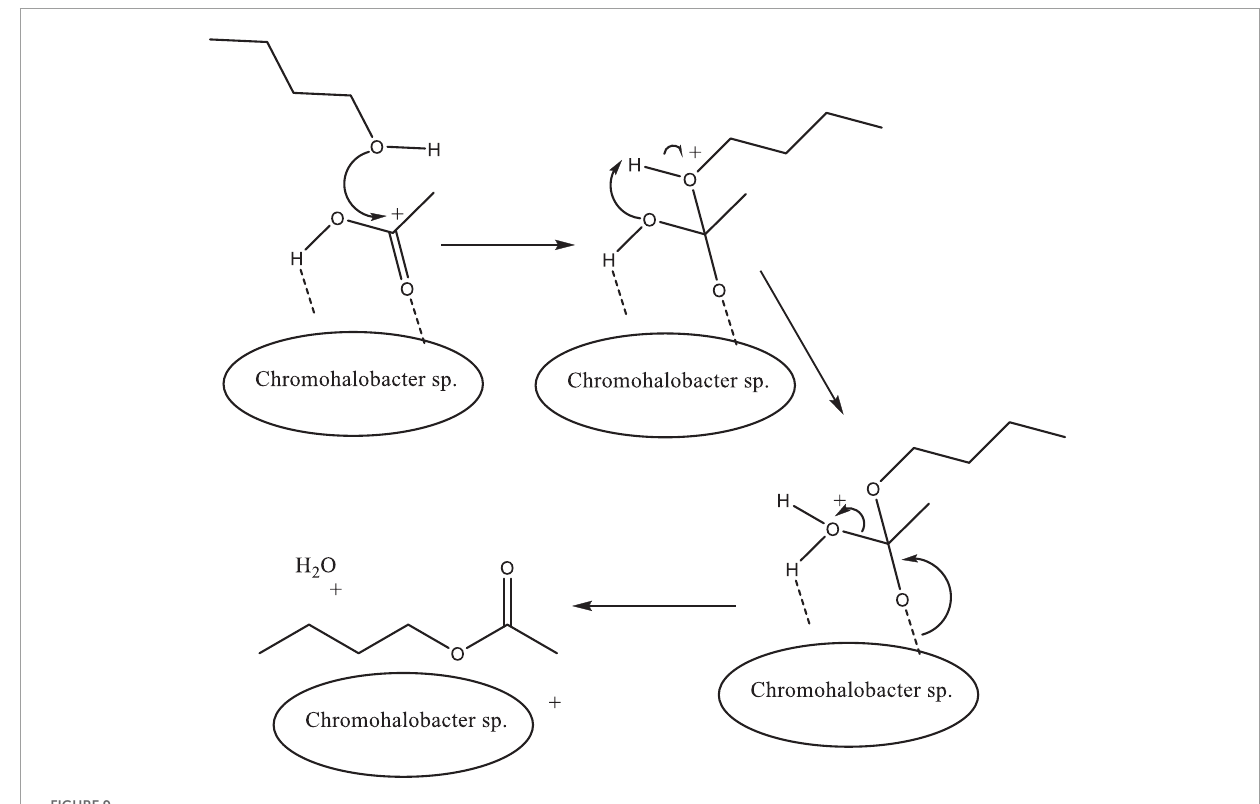
FIGURE9 Plausible proposed mechanism of esterification of butan-1-ol and glacial acetic acid using Chromohalobacter sp. as